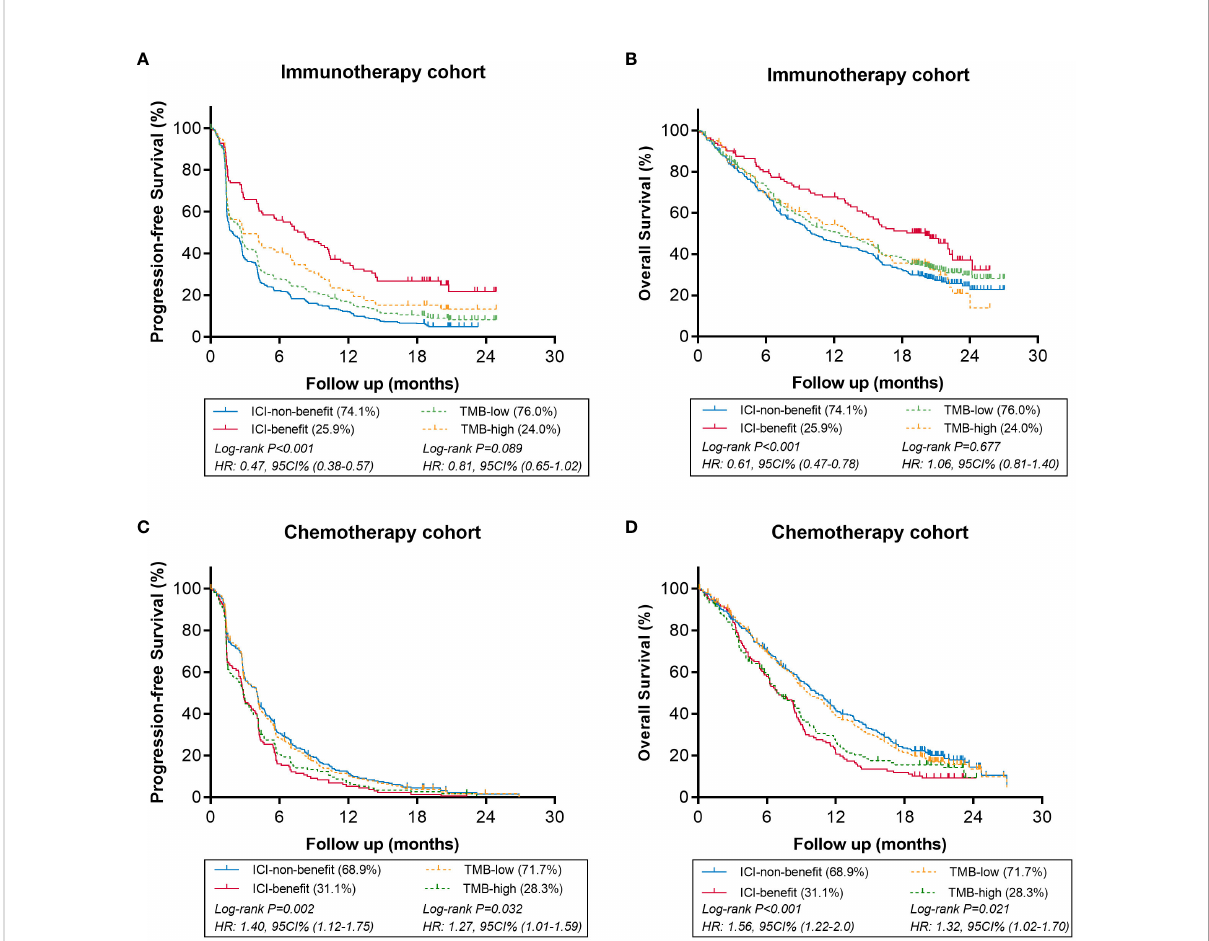
FIGURE 3 Comparison of survival in immunotherapy or chemotherapy arms using ML-signature (ICI-bene fi t vs. ICI-non-bene fi t) and TMB (high vs. low). (A, B) immunotherapy cohort, (C, D) chemotherapy